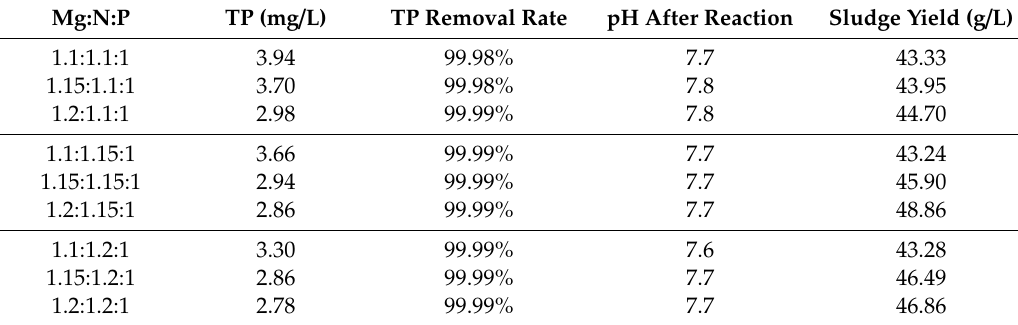
Table 3. Combination experiment of different Mg:N:P.